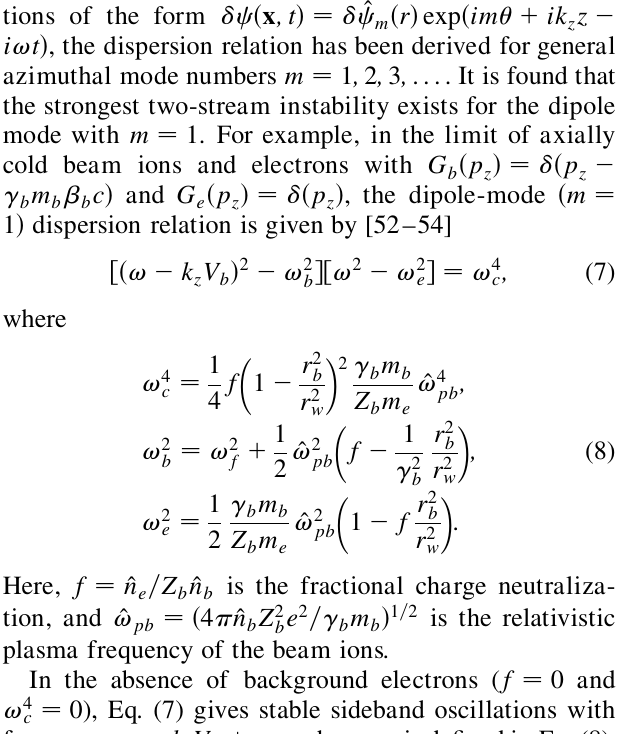
Fig. 4 is the time history of the beam density perturbation